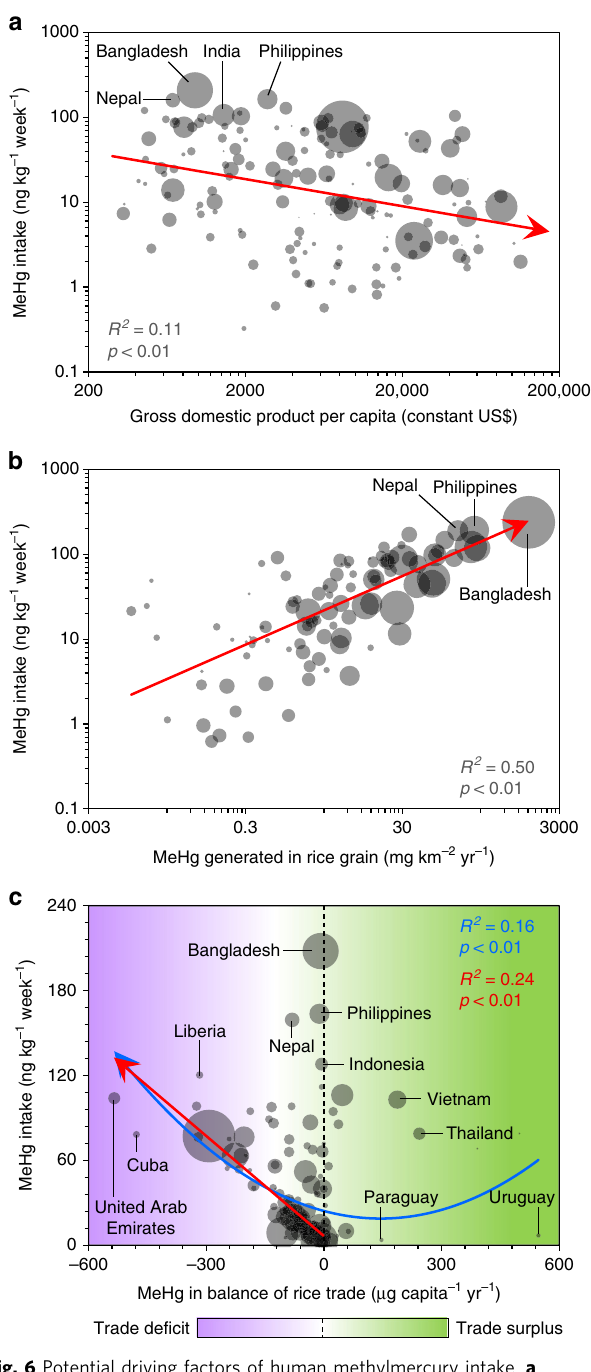
Fig. 6 Potential driving factors of human methylmercury intake. a Relationship of the per capita probable weekly intake (PWI) of MeHg through rice with the gross domestic product; b relationship of the PWI of MeHg through rice with amount of MeHg in rice grain; c relationship of the PWI of MeHg through rice with the international rice trade. The gross domestic product data were obtained from the World Bank (http://www. worldbank.org/). Sample size ( n ) = 163. The sizes of the dots in the fi